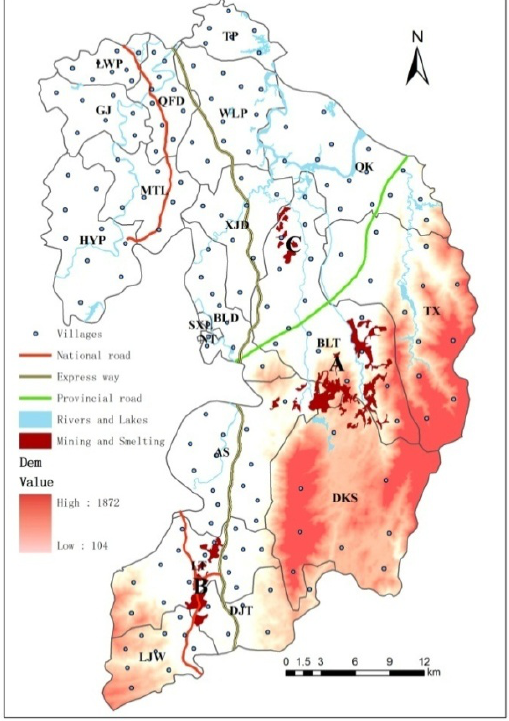
Figure 2. Suxian District, a metalliferous mining county in Chenzhou City, South